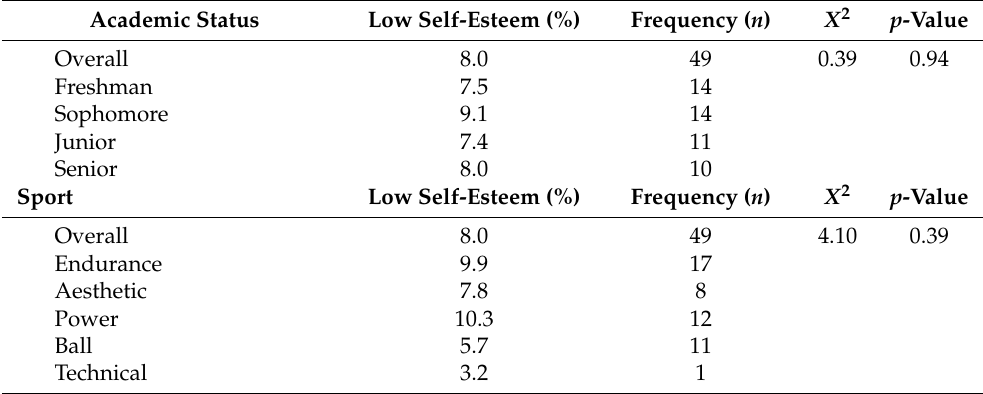
Table 6. Low Self-Esteem Prevalence by Academic Status and